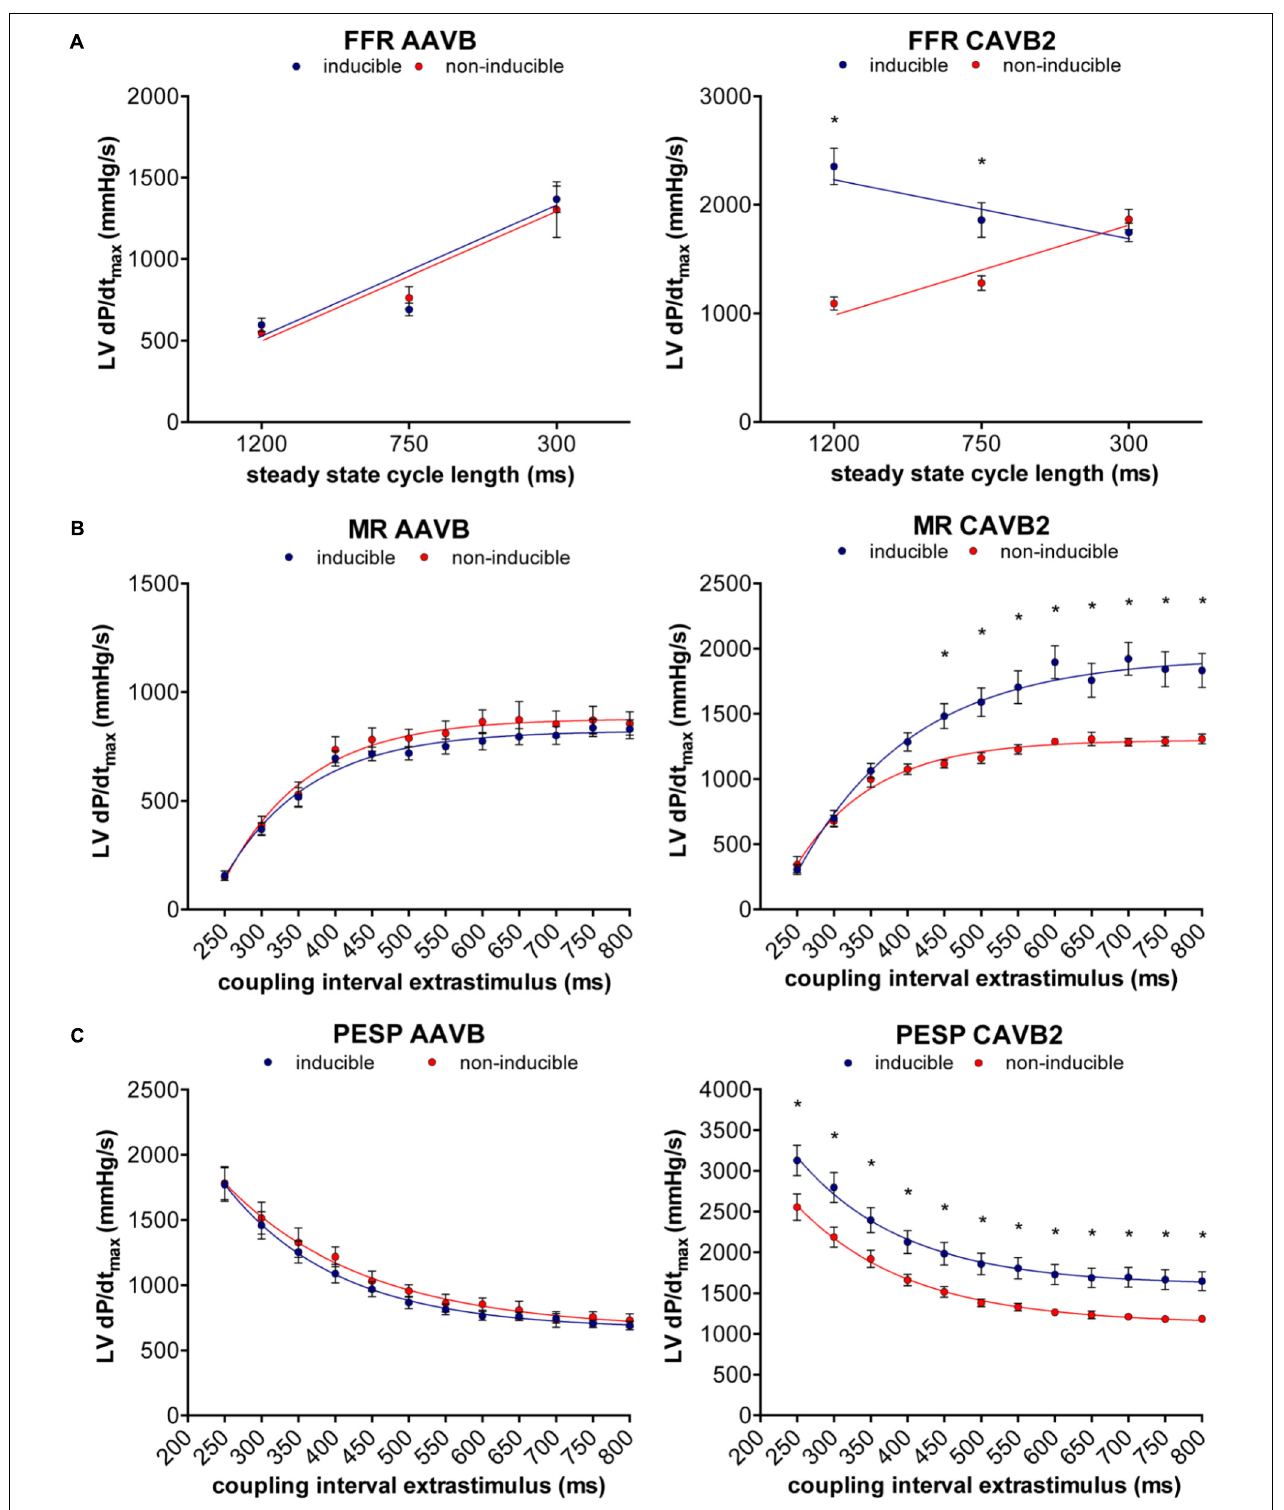
FIGURE 3 | Relation between contractile remodeling and susceptibility to TdP. (A) FFR, (B) MR, and (C) PESP of inducible dogs (blue line) and non-inducible dogs (red line) at AAVB (left) and at CAVB2 (right). ∗ p < 0.05 compared to non-inducible.